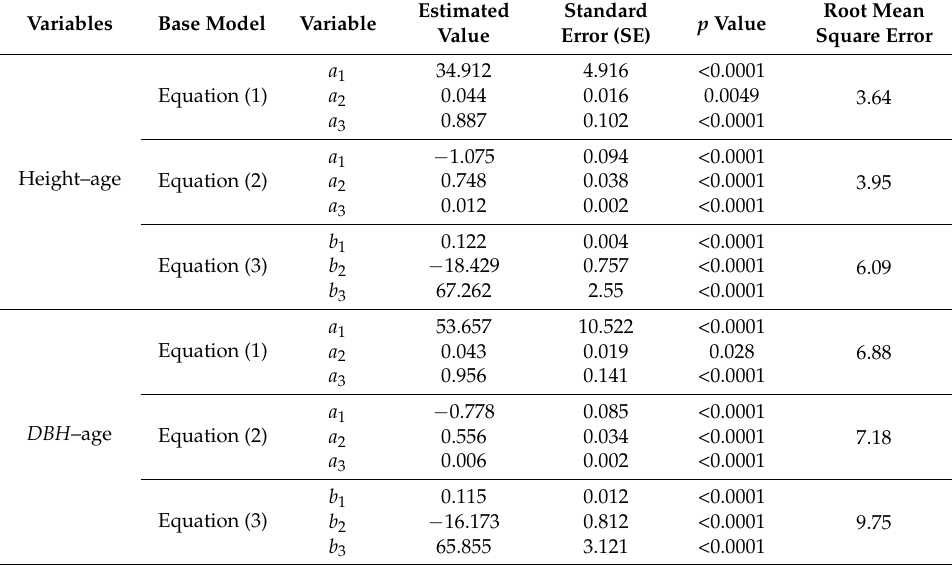
Table 3. Estimated values of parameters, p values and goodness-of-fit statistics for the three mean dominant height (m)—age and diameter at breast height ( DBH , cm)—age models for teak planted as living